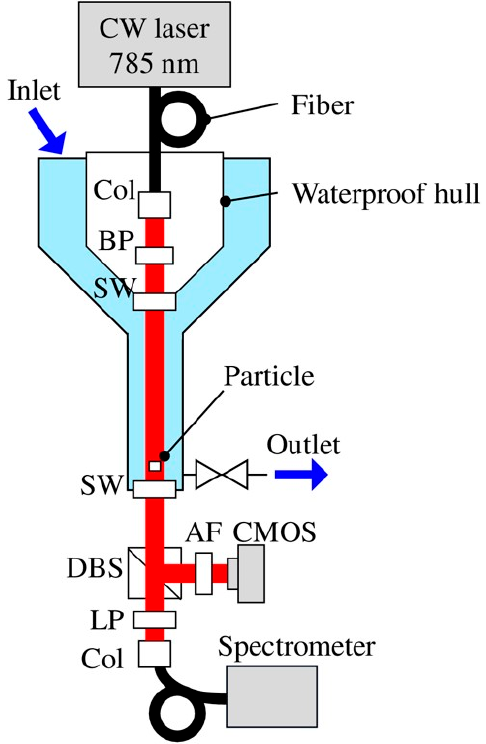
Figure 11. Experimental setup: Col, collimator; BP, bandpass filter; SW, sapphire window; DBS, dichroic beam splitter; AF, attenuation filter; and LP, long pass filter. Trapped particles are probed with holography and Raman techniques [130].